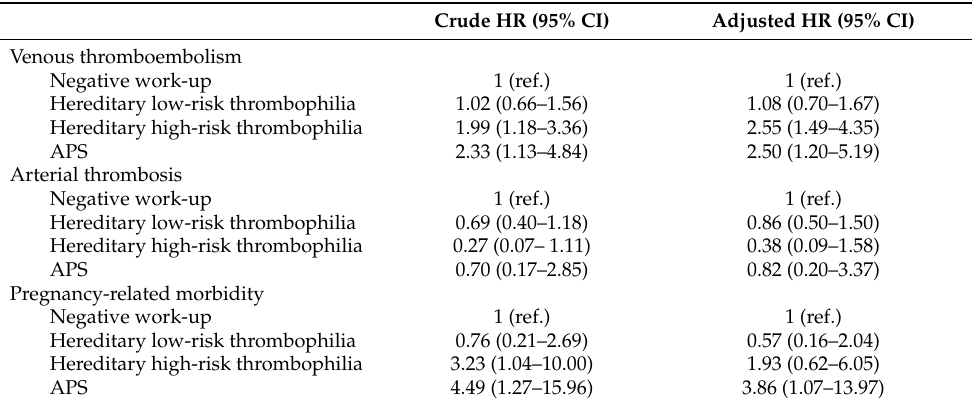
Table 5. Cause-specific hazard ratios for subsequent events after thrombophilia testing during follow-up according to thrombophilia